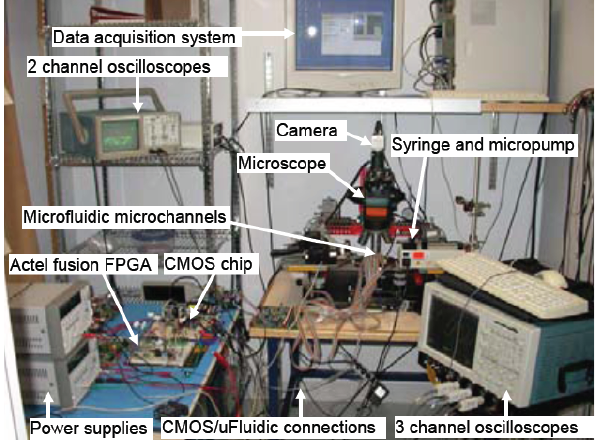
Figure 14. System set-up to test DEP effect on microspheres injected in a custom design of electrode architecture